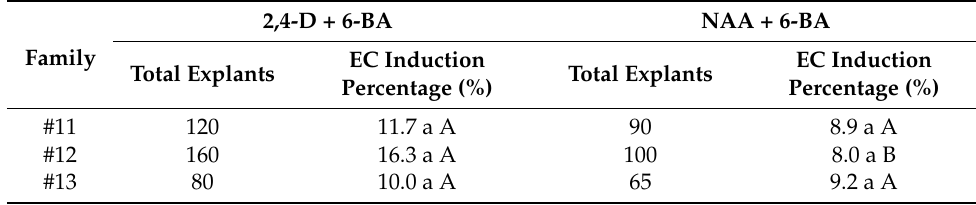
Table 4. Effects of hormone combinations on EC induction percentage of Korean